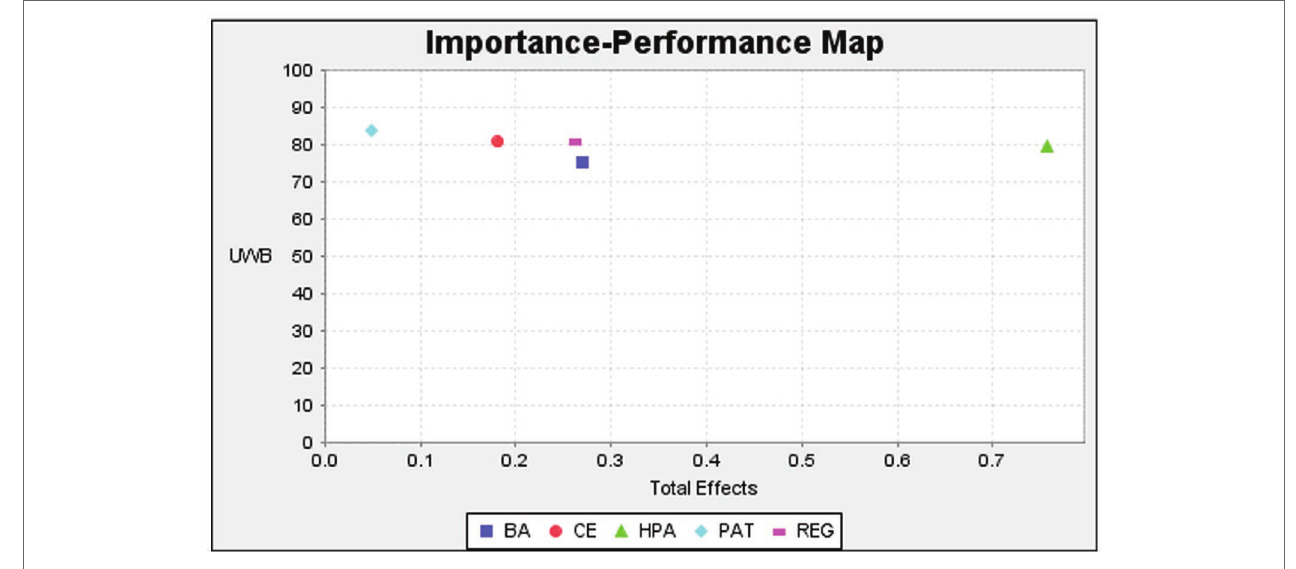
FIGURE 2 | Importance-performance map analysis (IPMA).